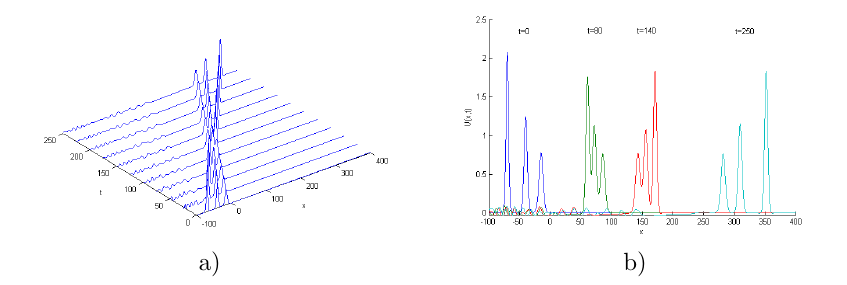
Figure 4. Three solitary waves for a = b = c = 1, d = 0 . 5, h = ∆t = 0 . 1, v 1 = 0 . 3, v